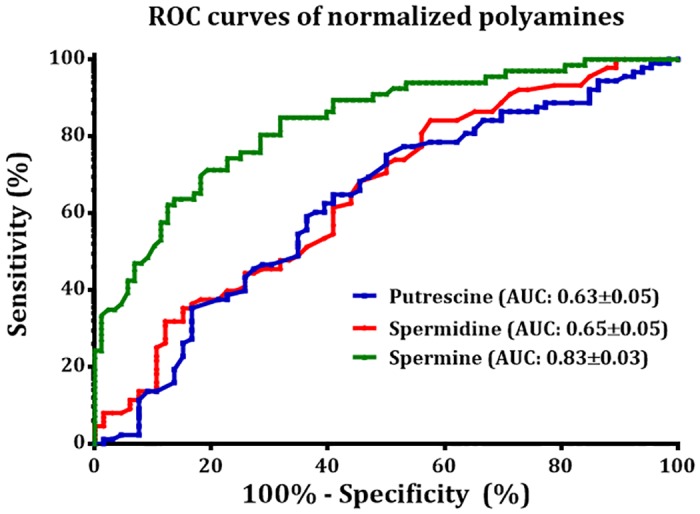
Receiver operating characteristic analysis for normalized Put, Spd and Spm values.